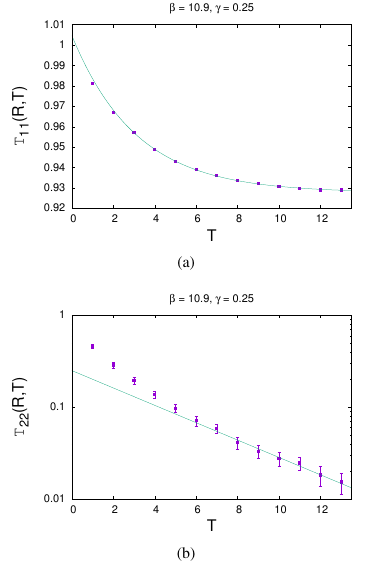
( R , T ) at R = 5 . 385 vs T in the e ↵ ective Landau- Figure 3. T nn Ginzburg model of superconductivity.